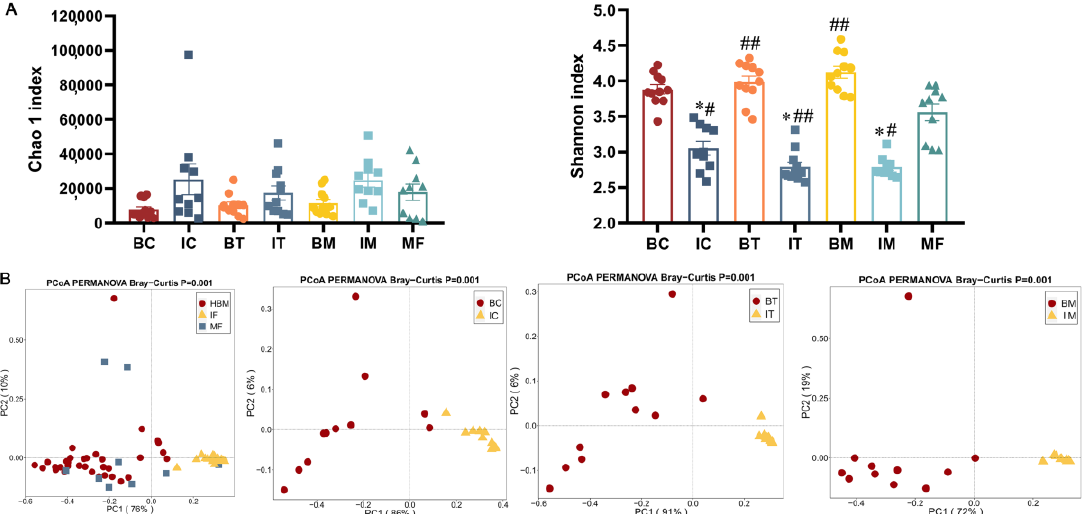
Figure 5. Diversity of total Bifidobacterium in HBM, infant and maternal feces. ( A ) Alpha diversity. ( B ) Beta diversity. PERMANOVA was used to calculate differences among samples based on Bray- Curtis distance. *, p < 0.05; three stages of infant feces compared to corresponding BC, BT, and BM. #, p < 0.05; ##, p < 0.01; three stages of HBM and infant feces compared to maternal feces. HBM, IF, MF stand for group HBM, infant and maternal feces. BC, BT, BM, IC, IT, and IM stand for colostrum, transitional milk, mature milk, and infant feces corresponding to HBM stages.